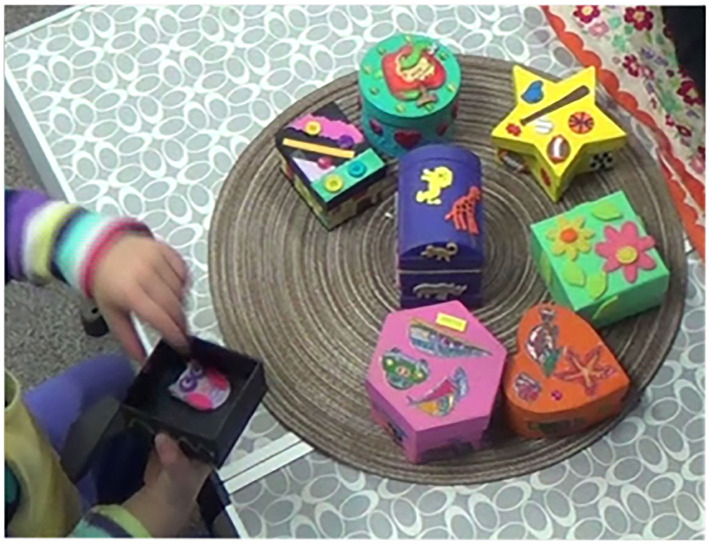
Spin the Pots task.